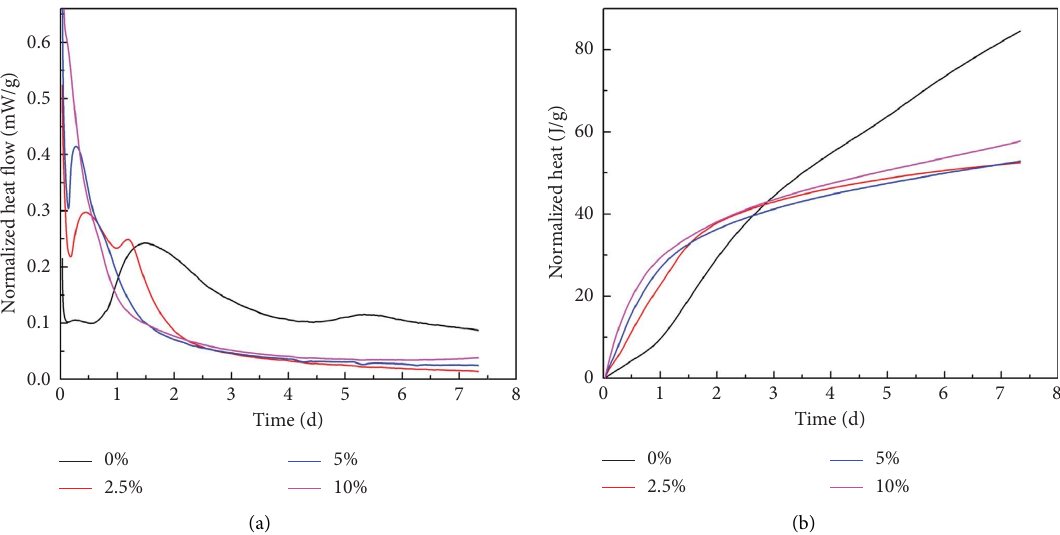
Figure 3: Te hydration exothermic curves of FCP with diferent sodium hydroxide contents at 20 ° C: (a) normalized heat fow; (b) normalized heat.